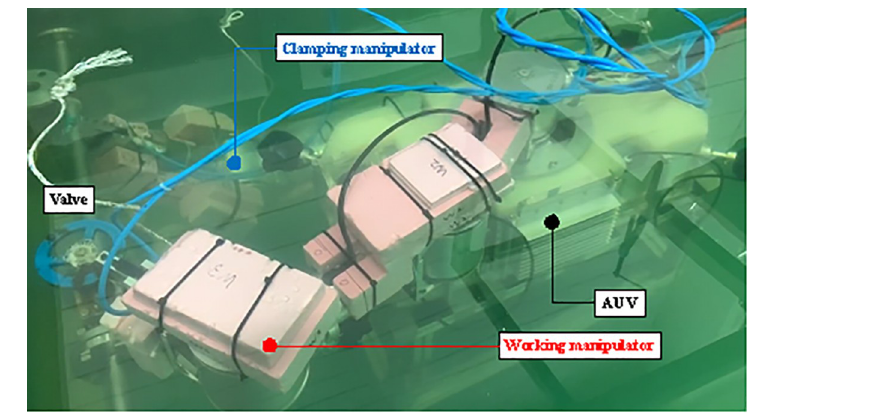
Fig 9. Experimental setting in the test bench.